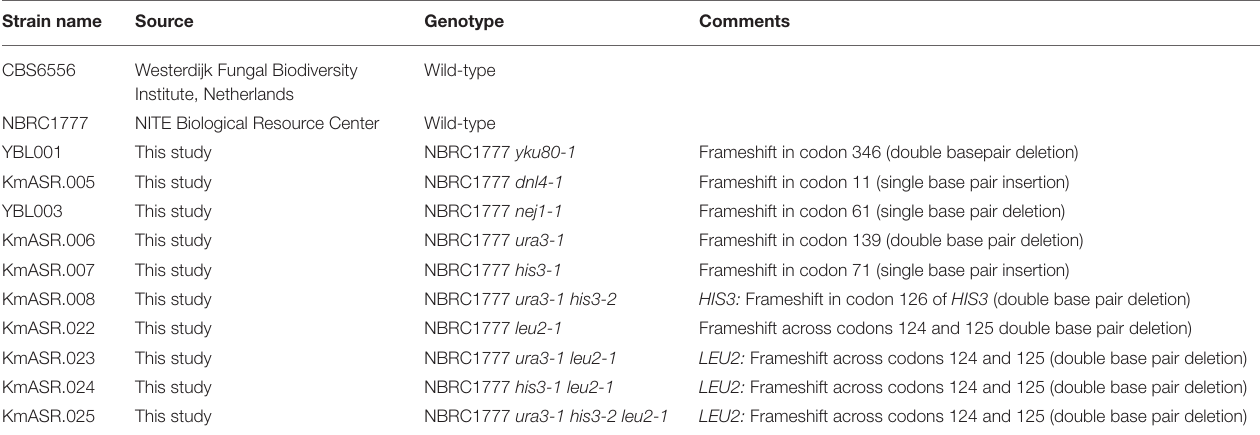
TABLE 1 | List of K. marxianus strains used in this